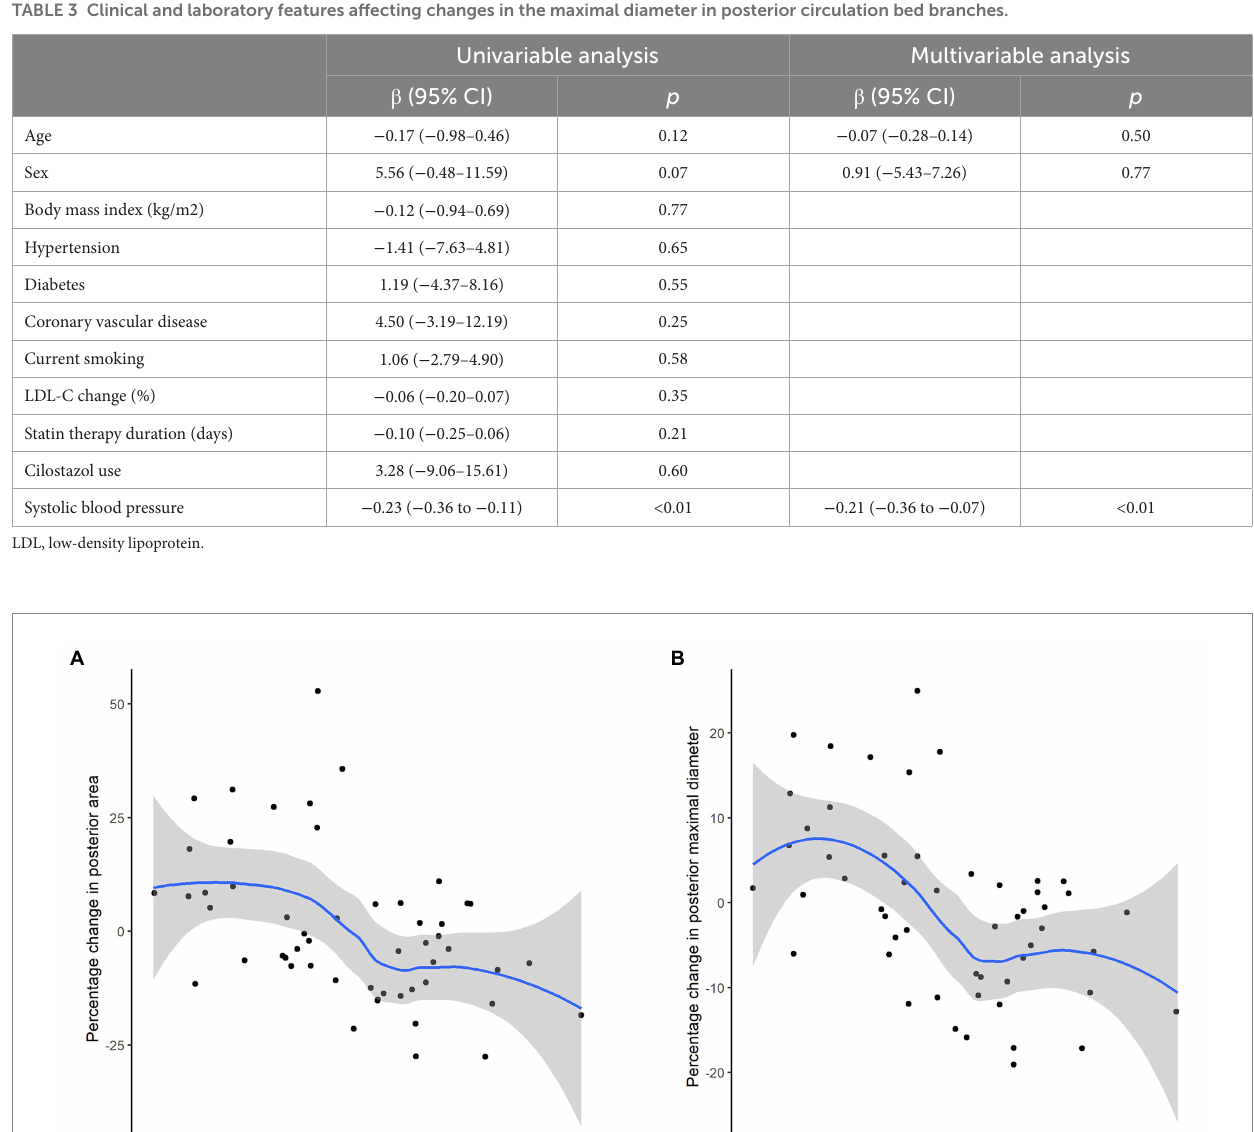
TABLE 3 Clinical and laboratory features affecting changes in the maximal diameter in posterior circulation bed branches.